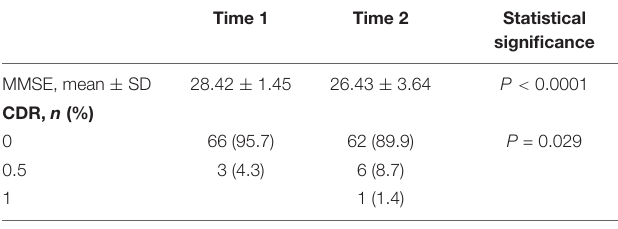
TABLE 2 | MMSE and CDR scores at Time 1 and Time 2.